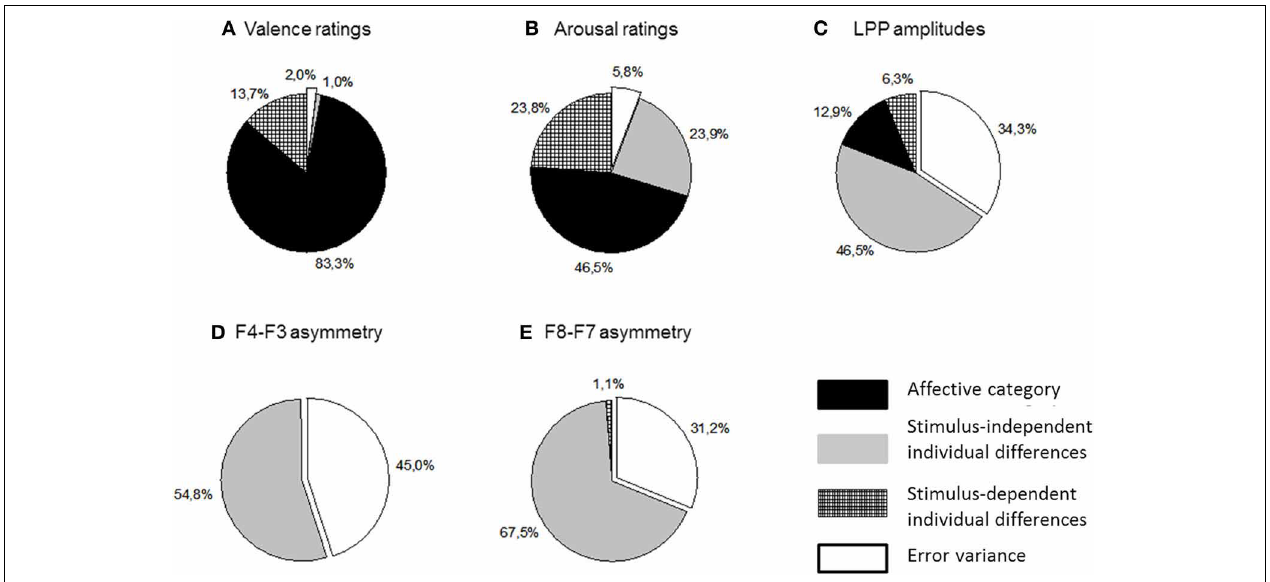
FIGURE 4 | Proportions of variance accounted for by the affective category and two types of individual differences (see Equation 1) in subjective valence (panel A) and arousal ratings (panel B); LPP amplitudes (panel C) and two asymmetry estimates (panels